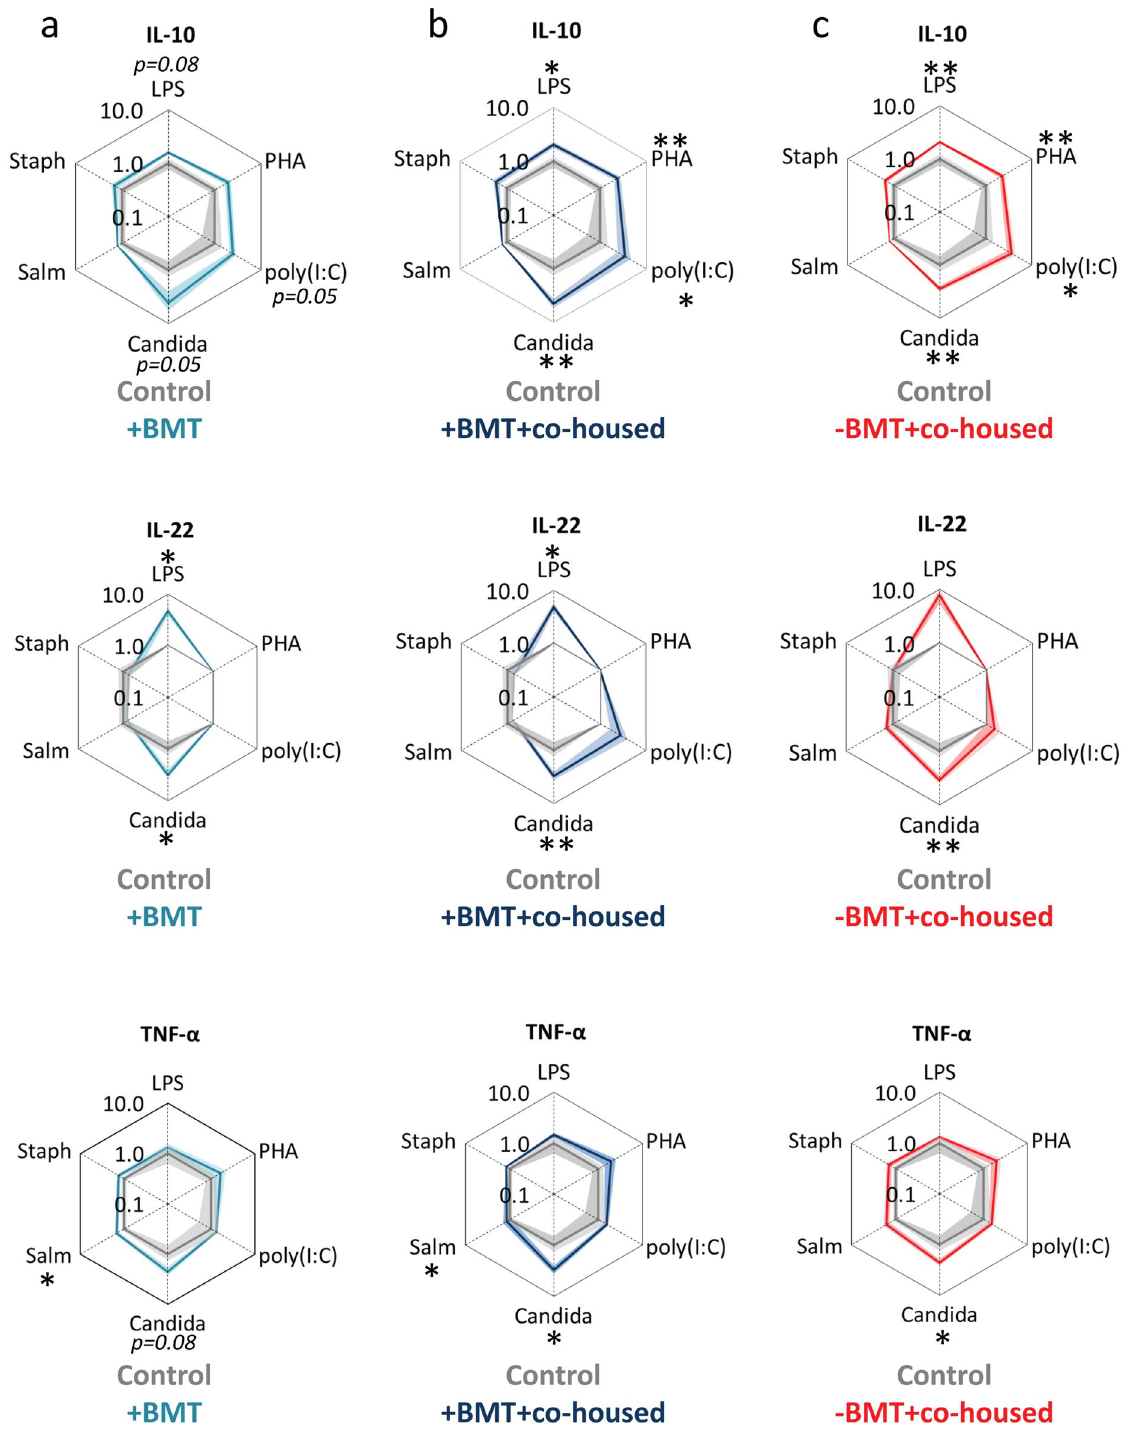
Figure 1. The effect of co-housing after BMT on cytokine secretion of stimulated splenocytes. Spiderplots show IL-10, IL-22 and TNF-α release in response to various pathogenic stimuli from splenocytes derived from ( a ) BMT-treated mice co-housed with BMT mice (outer light blue lines), ( b ) BMT-treated mice co-housed with healthy control mice (outer dark blue lines), and ( c ) control mice co-housed with BMT-treated mice (outer red lines). Cytokine concentrations in response to the stimuli are normalized to the cytokine concentrations of healthy control mice co-housed with control mice (inner grey lines), averaged per group and plotted on a log scale. Every corner of the spiderplot hexagon represents the response to one stimulus. The data lines and shades represent means and SEM, respectively; Groups were compared using Mann–Whitney U test; n = 5–6 per group; *p < 0.05; **p < 0.01. Candida, Candida conidia ; LPS, lipopolysaccharide; PHA, Polyhydroxyalkanoates; poly(I:C), Polyinosinic:polycytidylic acid; Salm, Salmonella typhimurium ; Staph, Staphylococcus aureus